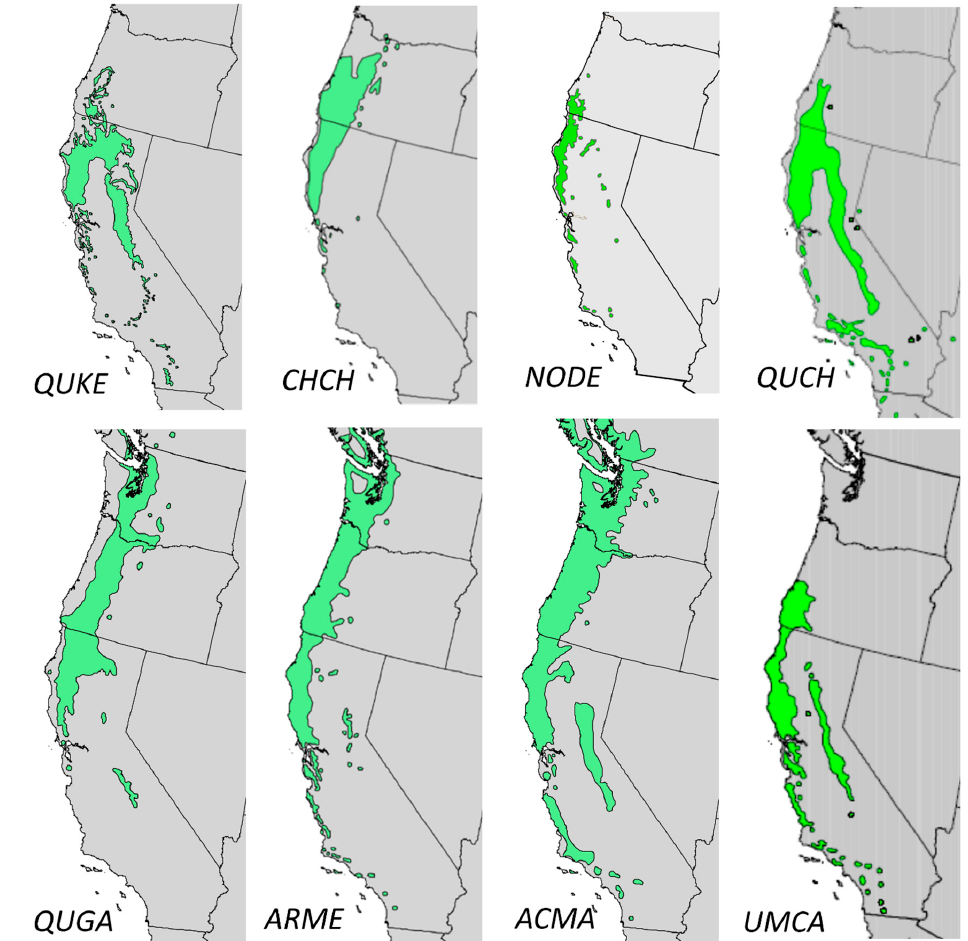
Figure 2. Distributions of the eight study species of hardwood trees within the far western USA from Little [57,58].